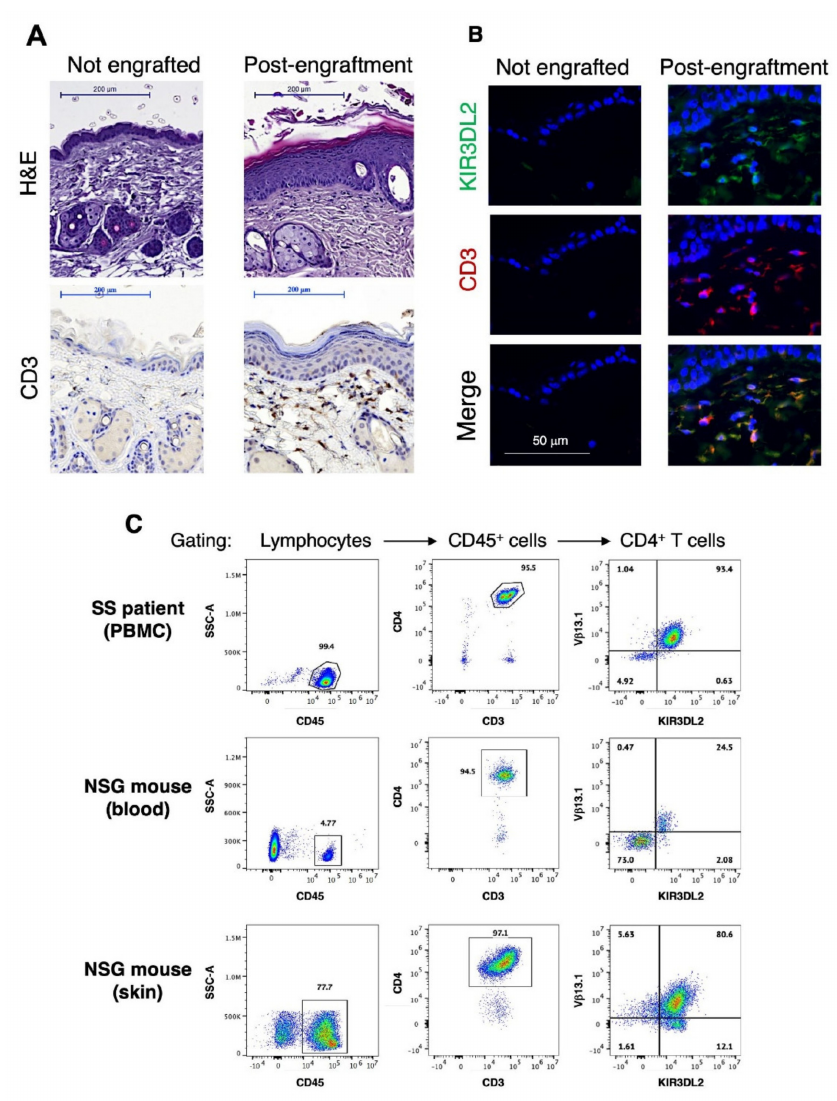
Figure 1. Main skin and blood features of the SS PDX mouse model. ( A ) Hematoxylin–eosin (upper panel) or CD3 (lower panel) staining was performed on skin sections from control (not engrafted) mouse (left) and 80 days after engraftment with S é zary patient’s PBMC (right). Scale bar = 200 µ m. ( B ) Skin sections from control (left panels) and engrafted (right panels) mice were subjected to immunofluorescence labeling using anti-KIR3DL2 (clone 12B11) and anti-human CD3 antibodies plus AlexaFluor488 (green)- and AlexaFluor594 (red)-coupled secondary reagents. Slices were mounted using a Dapi-containing mounting medium (blue). Scale bar = 50 µ m. ( C ) Flow cytometric analysis of the tumor T cell clone following mice engraftment. S é zary patient PBMC (upper panels) and lymphocytes recovered either in the blood (middle panels) or after collagenase extraction of a skin fragment (bottom panels) of a representative engrafted mouse were labeled with a mix of anti-human CD45, CD3, CD4, KIR3DL2 and TCR-V β antibodies. Following successive gating of lymphocytes, CD45 + cells and CD4 + T cells, the patient original malignant T cell clone was identified through its TCR-V β 13.1 rearrangement and expression of KIR3DL2 tumor